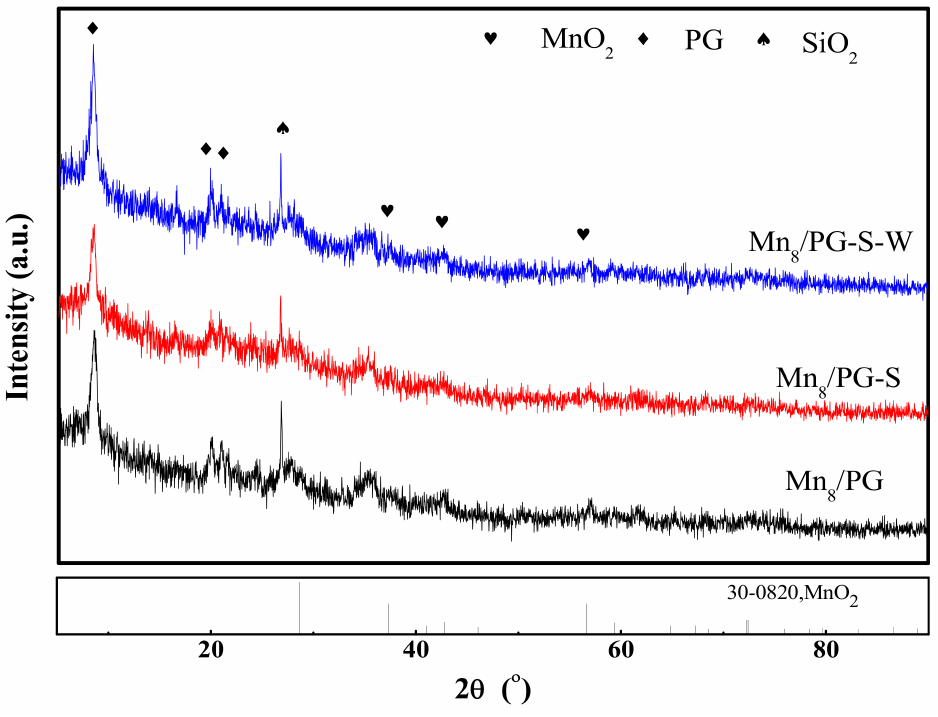
Figure 1. X-ray diffraction patterns for the